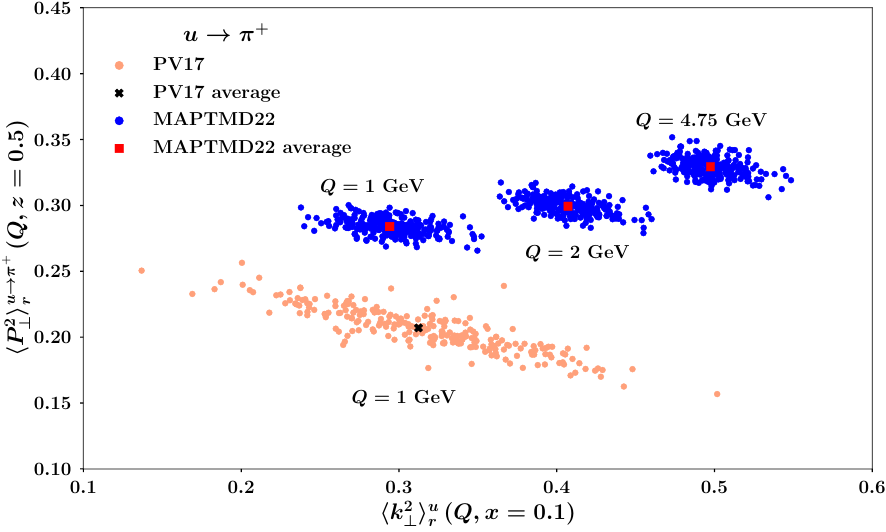
Figure 16 . Scatter plot of average squared transverse momenta for the TMD PDF of the up quark at x = 0 . 1 and for the TMD FF of the u π + fragmentation at z = 0 . 5 . Orange circles for the → PV17 analysis [5] at NLL at Q = 1 GeV; the black cross represents the average. Blue circles for this analysis (MAPTMD22) at N 3 LL − and at Q = 1, 2, 4.75 GeV; the red squares represent the average values for each considered Q